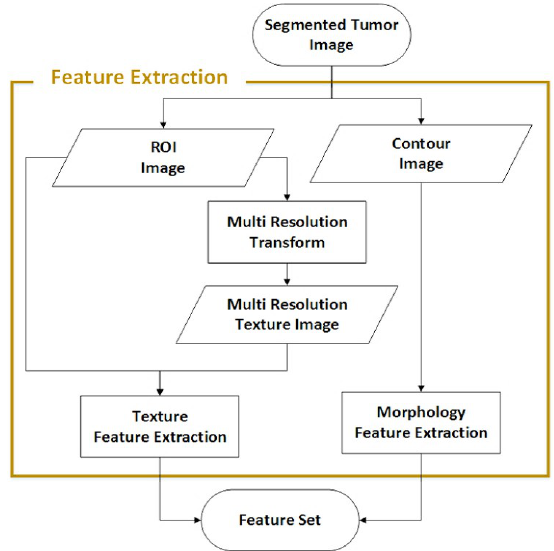
Figure 7. The flowchart of the BI-RADS feature extraction